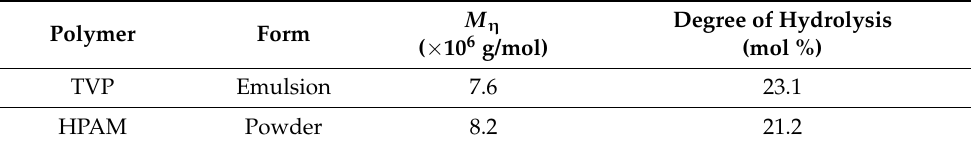
Scheme 1. The molecular structures of TVP and HPAM used in this work. Table 3. Physical parameters of TVP and HPAM used in this work. Table 3. Physical parameters of TVP and HPAM used in this work.